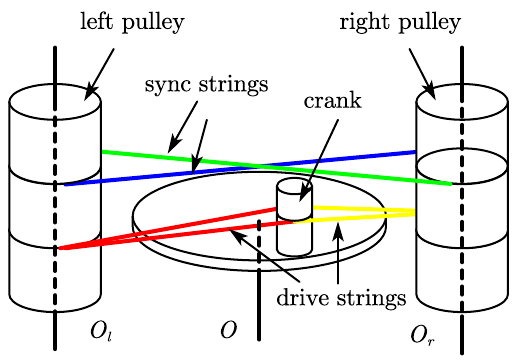
Figure 1. The schematic of the string-based flapping wing mechanism.